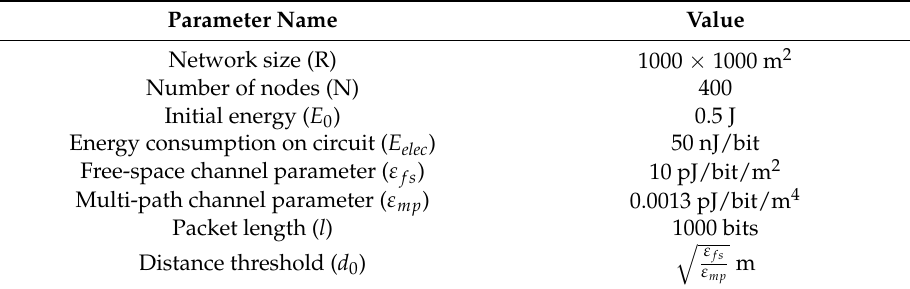
Table 2. Simulation parameters.